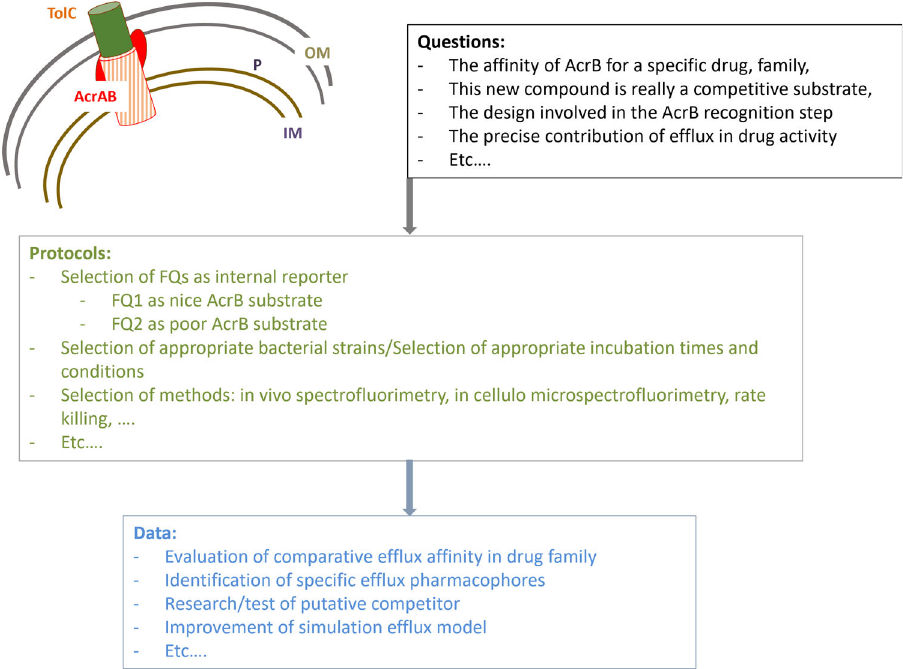
Fig. 8 General design principles of the competition ef fl ux method. The ef fl ux competition assay used here can be extended to other drugs using appropriate protocols to investigate several questions about bacterial ef fl ux pump systems. The fi gure shows examples of these questions and protocols, as well as the type of data that can be obtained from this